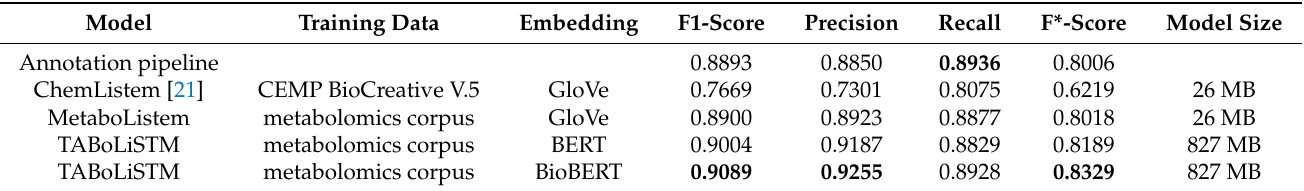
Table 3. Summary of model performance. Models are evaluated in terms of F1-score, precision and recall rate, and F*-score using the metabolomics corpus test set (183 manually annotated full-text articles). The best results for each metric is highlighted in